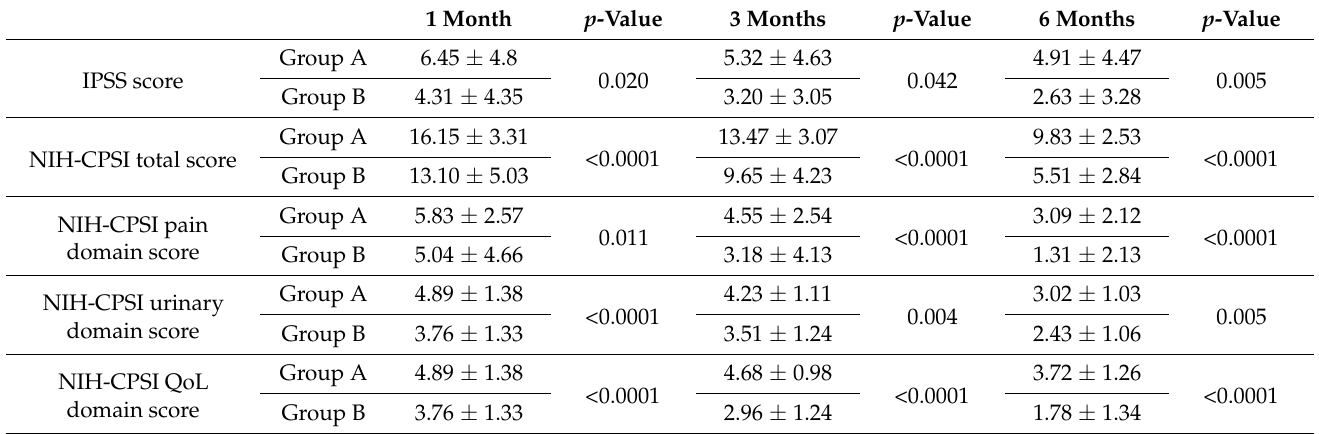
Figure 2. NIH-CPSI total score from baseline to 6 months after treatment. Table 2. Comparison between the two groups at 1, 3 and 6 months after